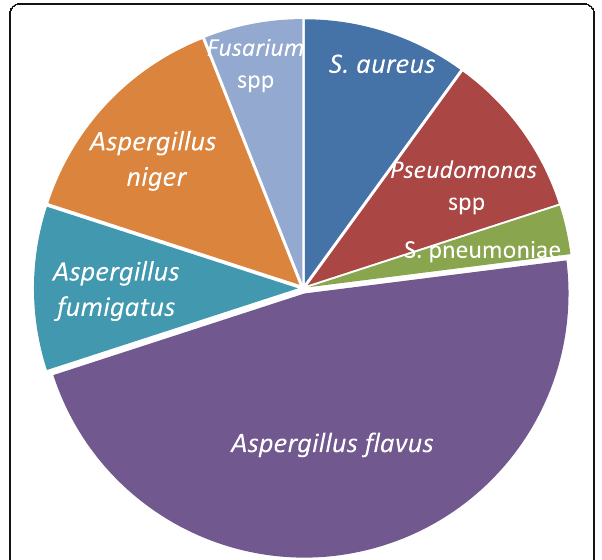
Fig. 3 Bacterial and fungal pathogens recovered from culture-positive